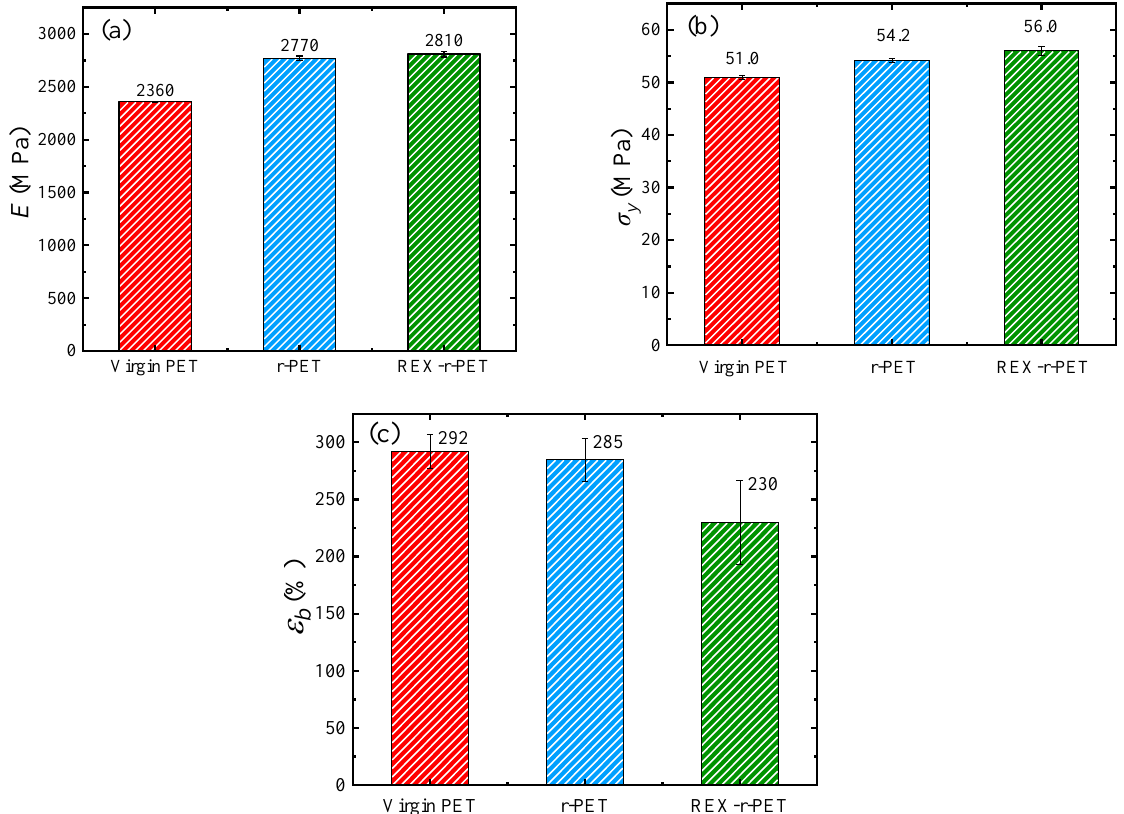
Figure 13. ( a ) Young’s modulus, ( b ) yield stress, and ( c ) strain-at-break values of virgin PET, r-PET, and REX-r-PET.